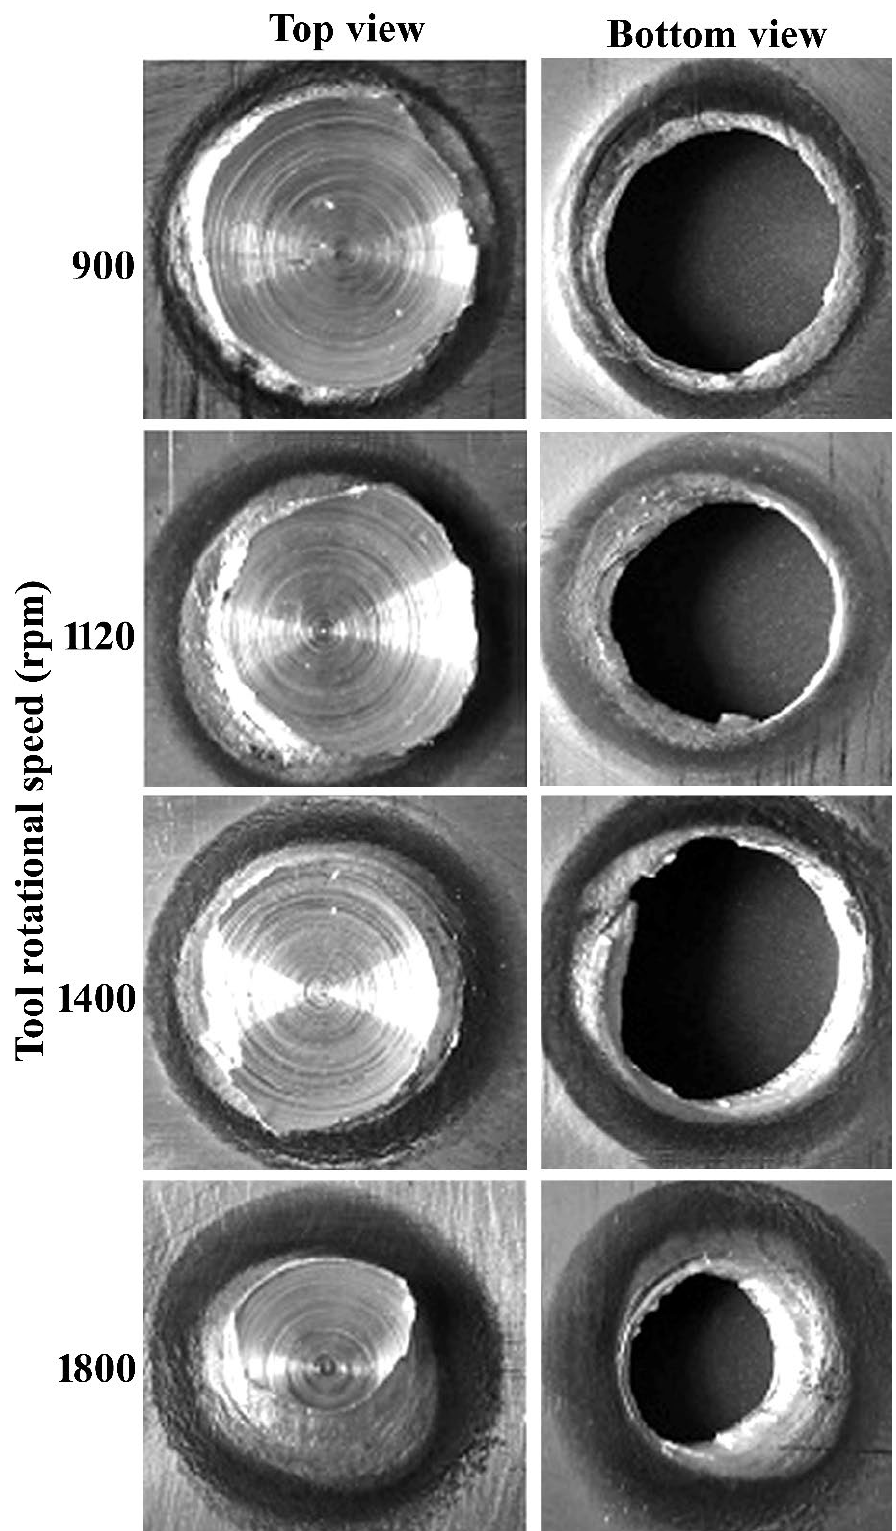
Figure 7. Macroscopic appearance of different modes of fracture made by the R-FSSW.